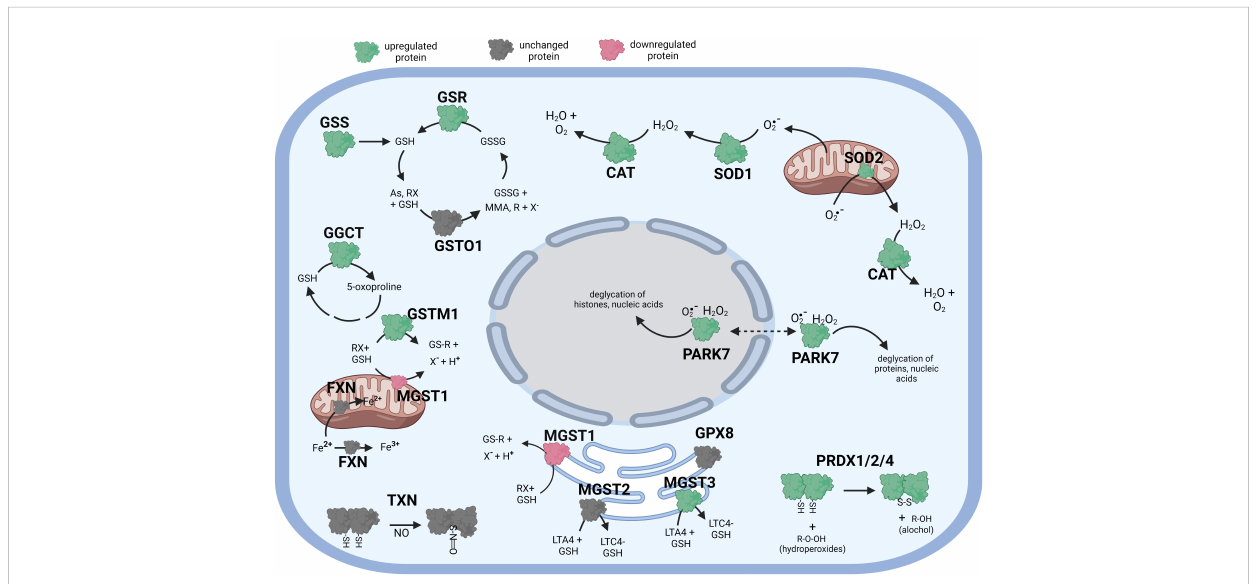
FIGURE 2 Diagramatic summary of the effect of a T exposure on antioxidant protein expression in hTERT-RPE cells. The antioxidant proteins focused on in this study are either upregulated (green), downregulated (red) or unaffected (no change in expression) (grey) by exposure to a T. The arrows indicate the direction of a chemical reaction. Exposure of hTERT RPE cells to a T led to an increase in several proteins involved in glutathione homeostasis and transfer including GSR, GGCT and MGST3. Exposure to a T also incerased the expression of PRDX1, PRDX2, PRADX4, SOD1, SOD2, CAT and PARK7. Figure created with BioRender.com.